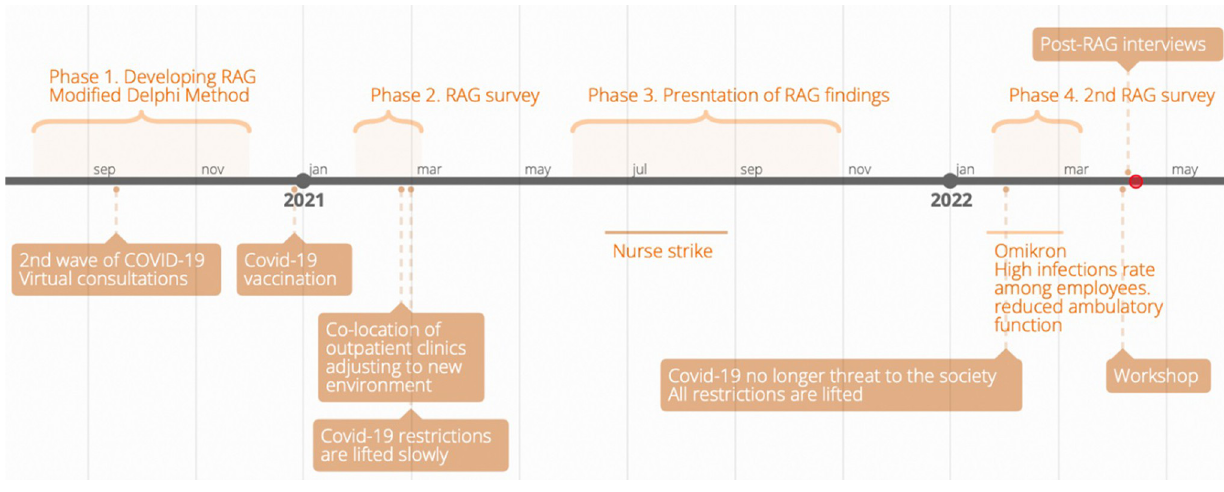
Fig 1. Timeline of the